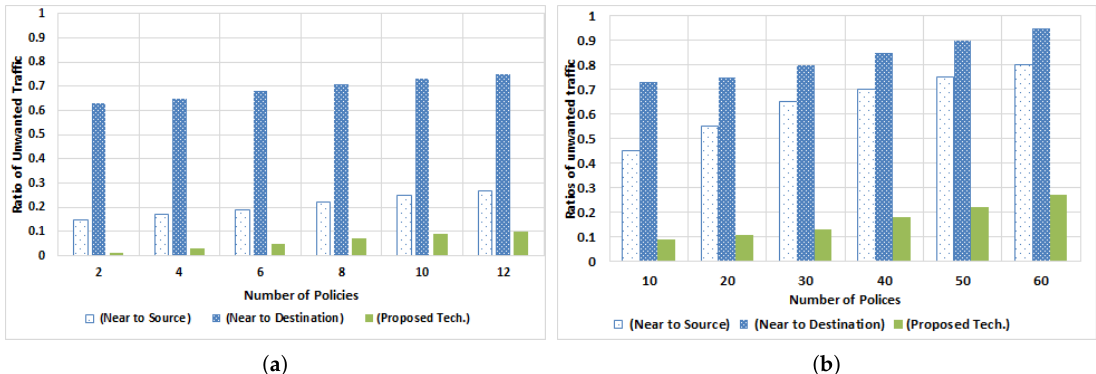
Figure 19. Simulation results of proposed and existing approaches for Traffic Optimization. ( a ) Traffic Optimization when the Number of policies is varying, and the number of switches is constant; ( b ) Traffic Optimization when the Number of policies is varying and number of switches is constant.